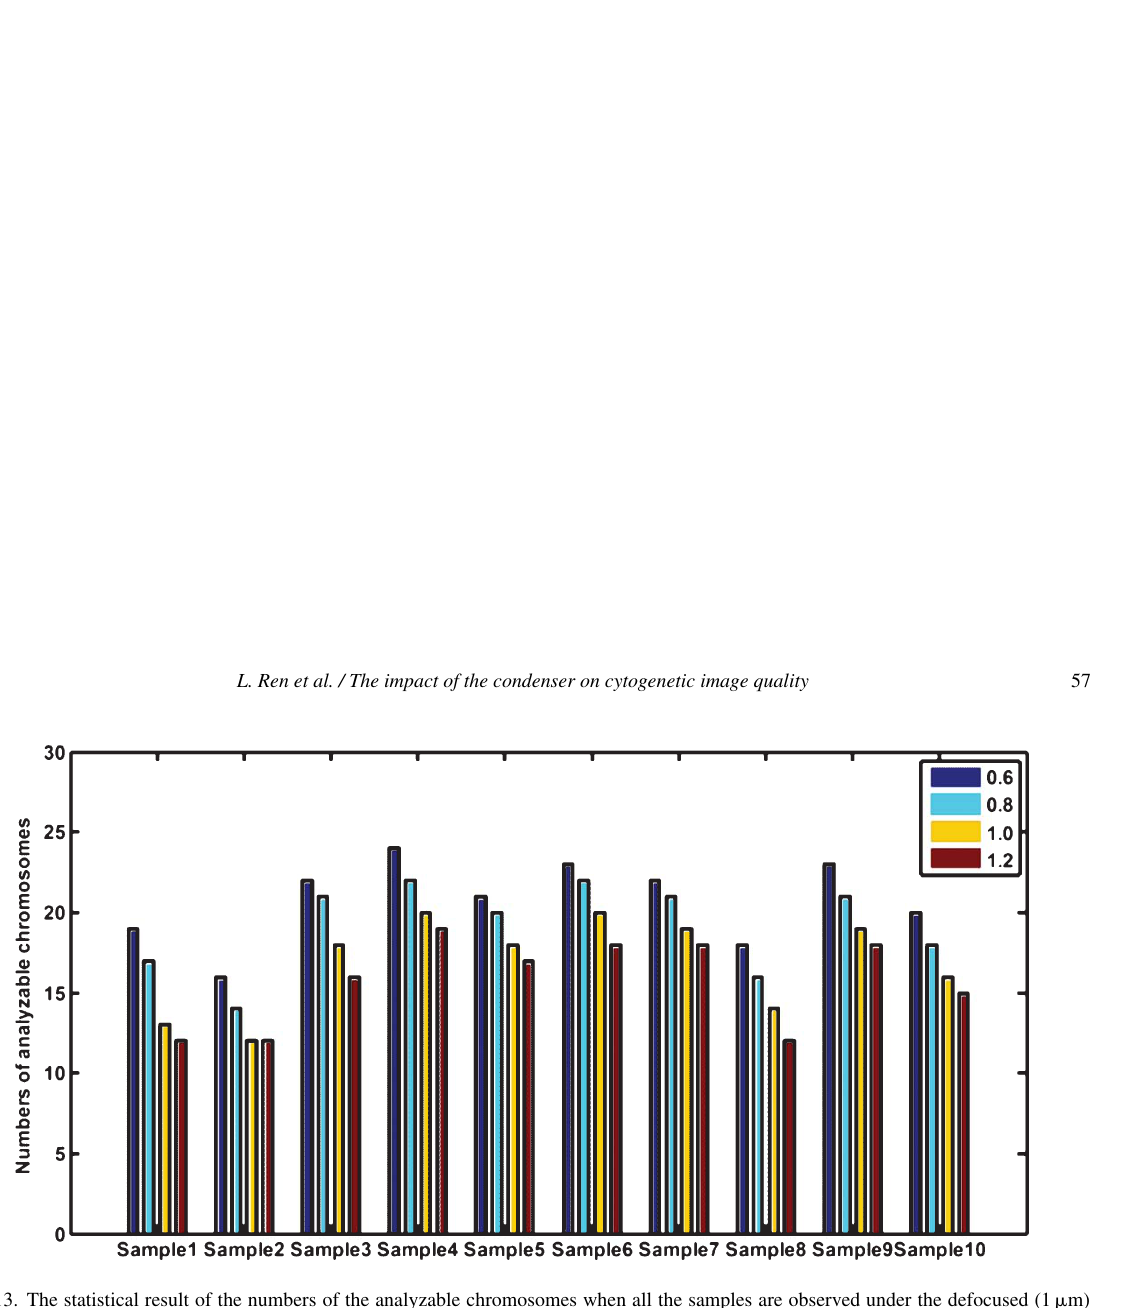
Fig. 13. The statistical result of the numbers of the analyzable chromosomes when all the samples are observed under the defocused (1 (cid:2) m) condition; for each sample, four bars from left to right represent the number of analyzable chromosomes under defocused condition of s =0.6, 0.8, 1.0 and 1.2,